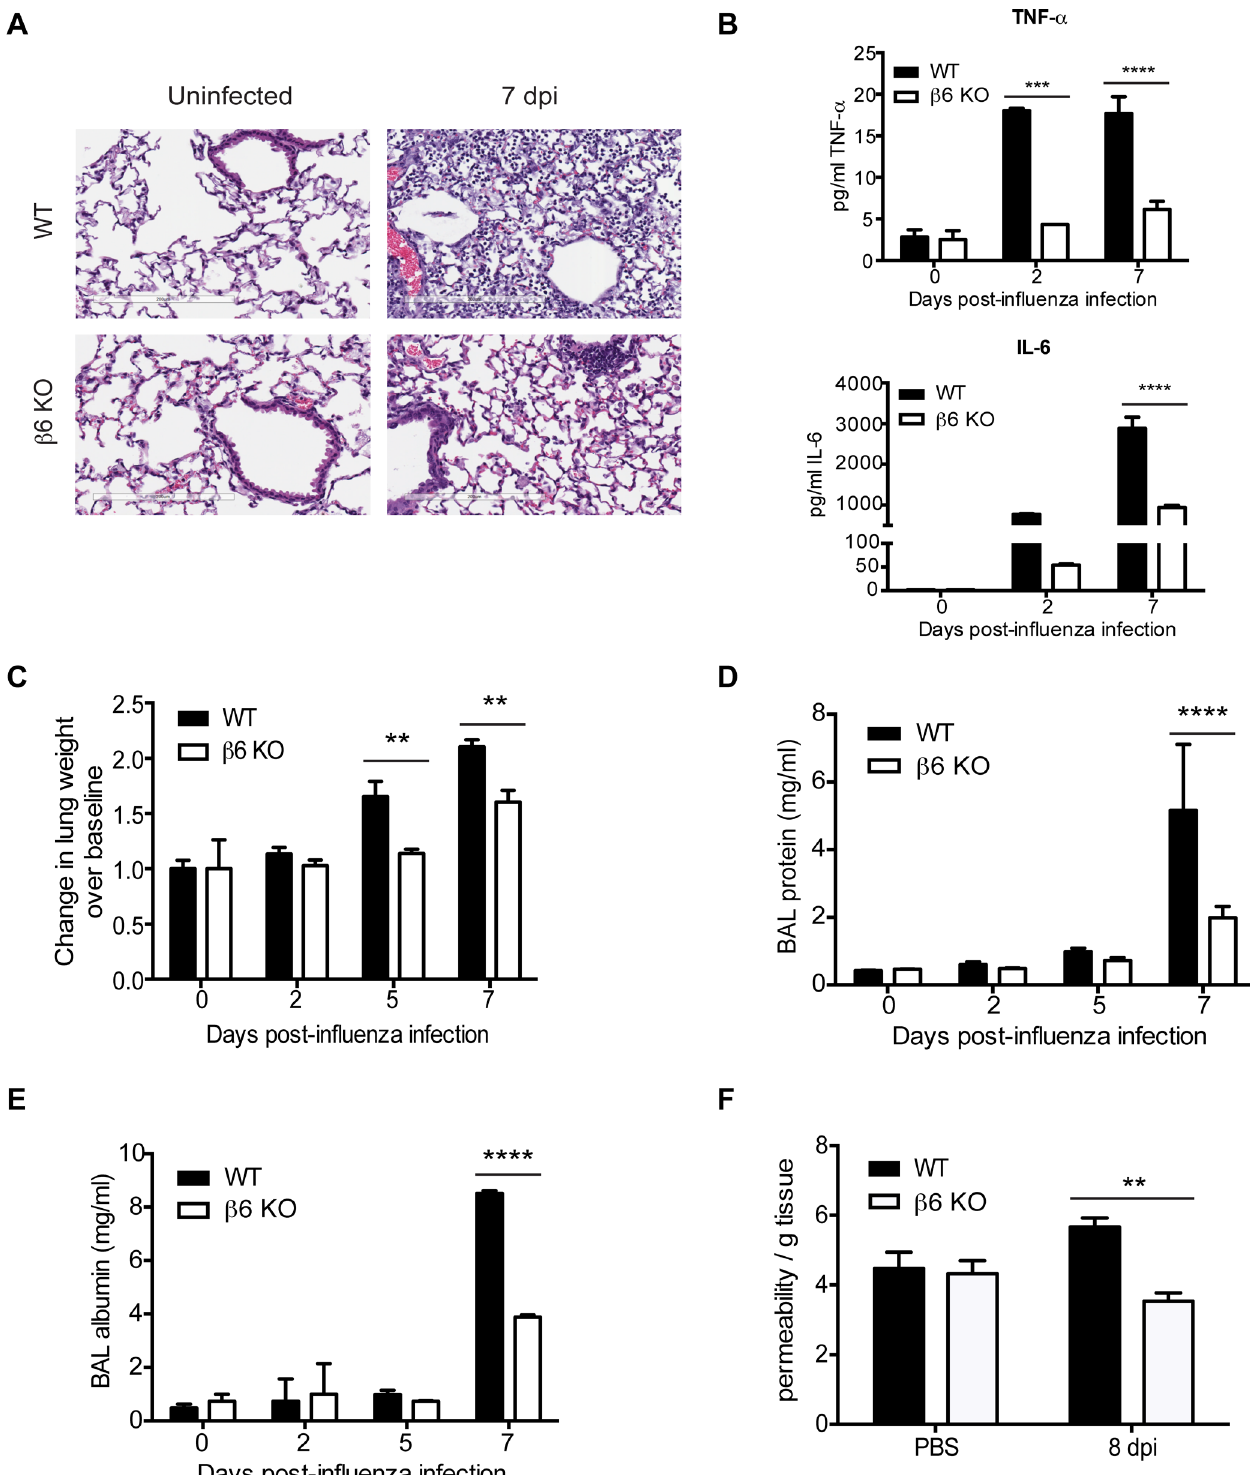
Fig 2. Lack of β 6 correlates with improved lung permeability during influenza virus infection. (A) Whole lung sections from CA/09 H1N1 influenza virus inoculated mice as described in Fig 1 were stained by H&E. Data are representative from 6 independent experiments with n = 2 – 4 mice per group. Bar = 200 μ m. (B) TNF- α (upper panel) and IL-6 (lower panel) were quantified from the BALF of infected mice by ELISA. (C) Lungs from CA/09 H1N1 influenza virus inoculated mice sacrificed at 2, 5, and 7 dpi were harvested and immediately weighed then dried at 60°C